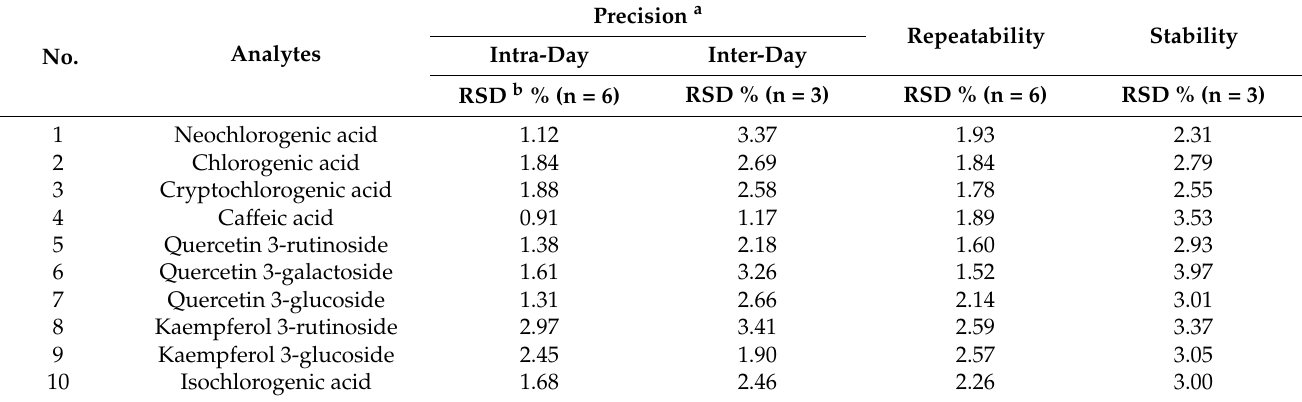
Table 4. Precision, repeatability, and stability results of 10 compounds.